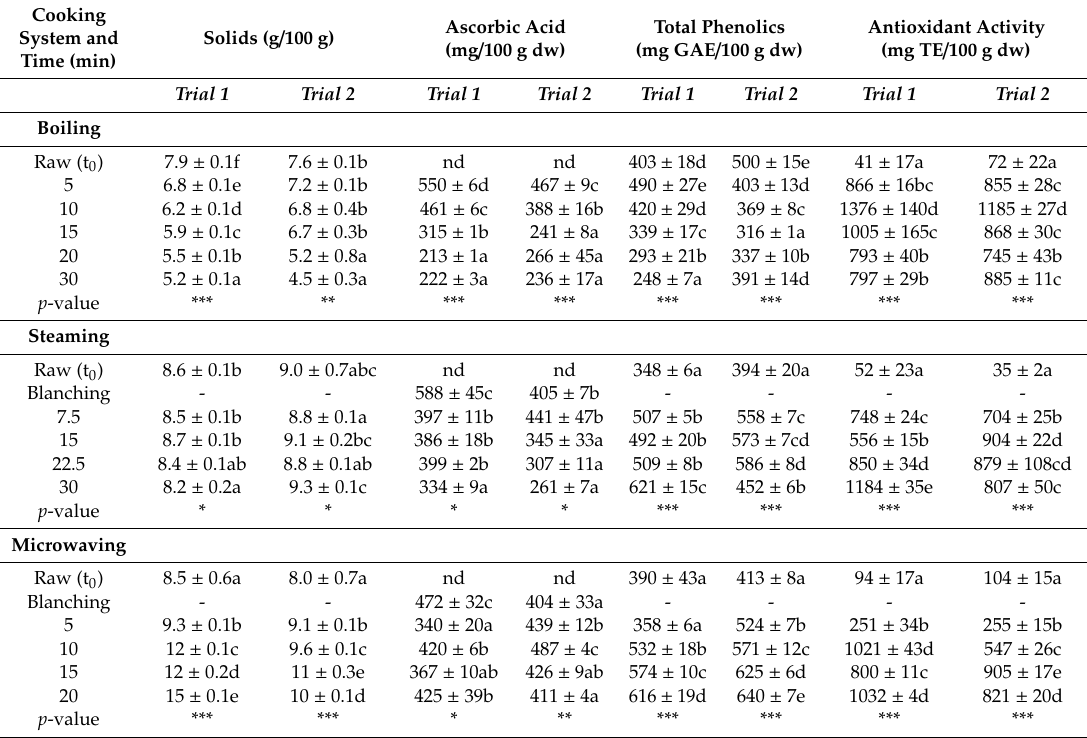
Table 1. Nutritional properties of cauliflowers cooked by di ff erent cooking systems and